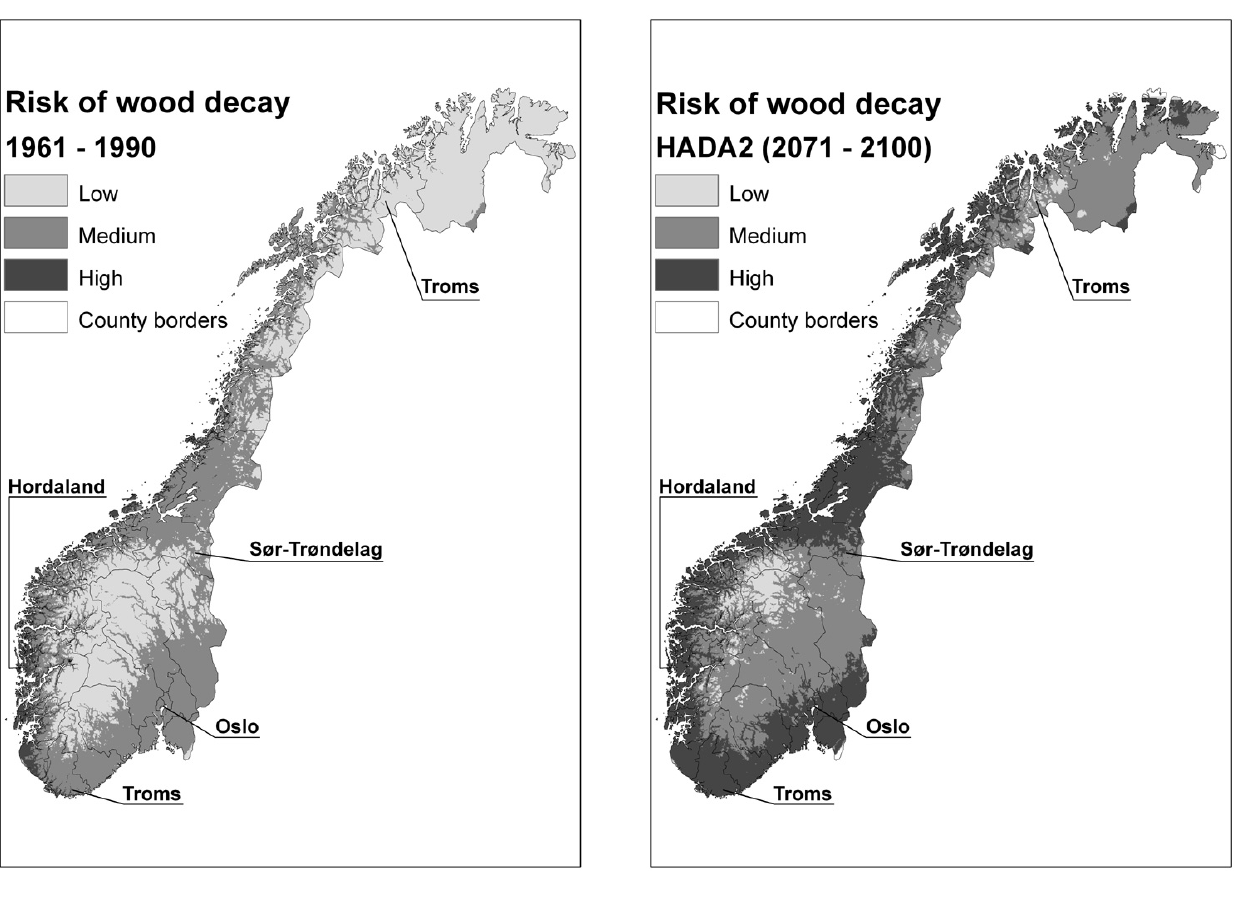
Figure 1. Map of Norway classified in risk of wood decay in a normal climate. Counties selected in Table 1 are marked.